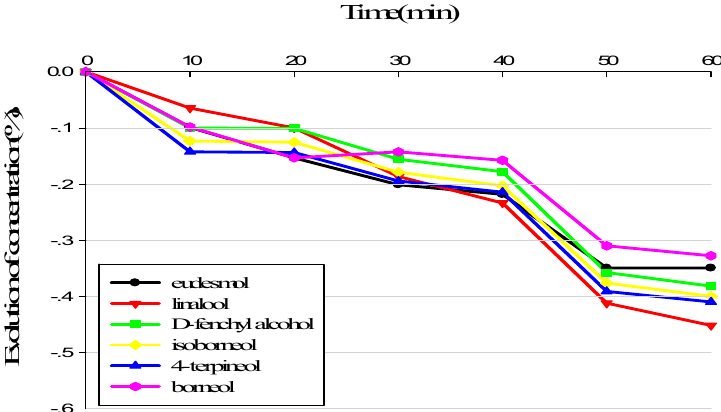
Figure 1. Volatie loss of terpene alcohols over time in sensory analysis in alkane solution.